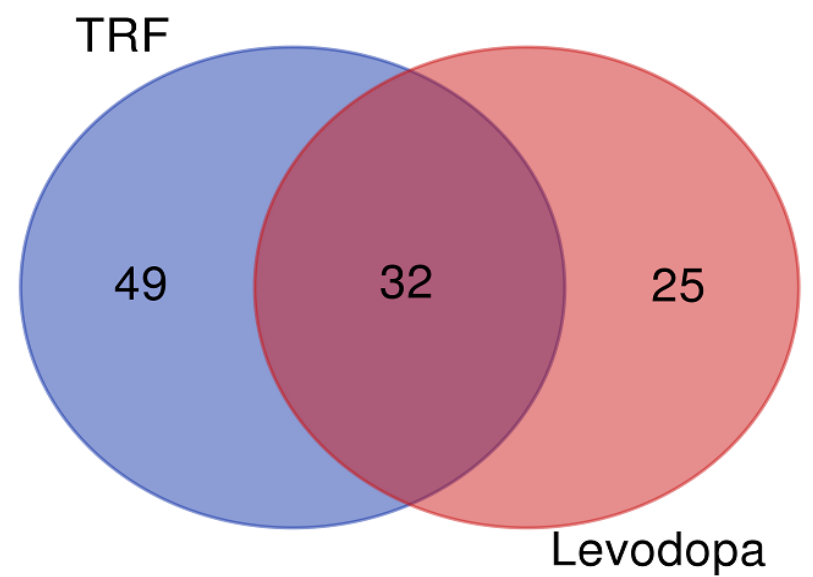
Figure 1. The Venn diagram. The union of intersection of differentially expressed proteins (p < 0.05) in diff-neural cell in response to TRF and levodopa treatments. Table 3. List of unique and common proteins between the levodopa and TRF treatment on diff- neural cell.